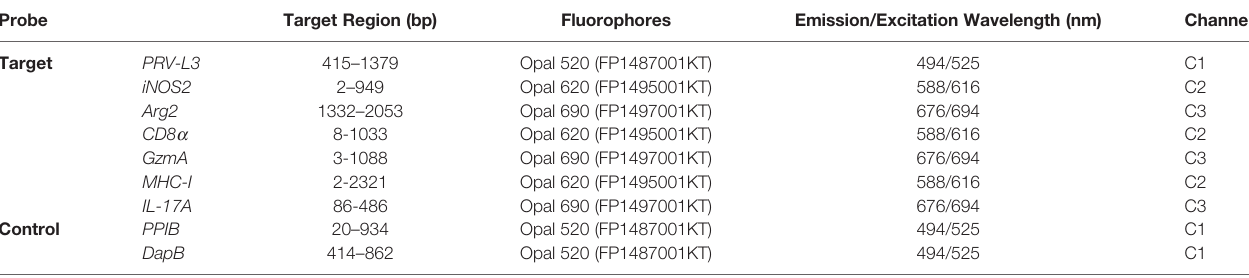
TABLE 2 | Probes used in FISH